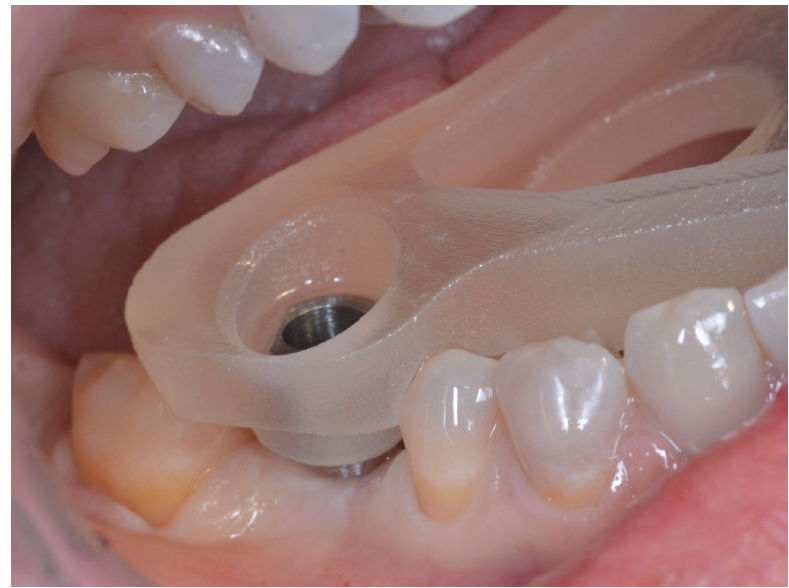
Figure 5. Intraoperative view of a detail of the surgical template, showing the edge of a guided sleeve.